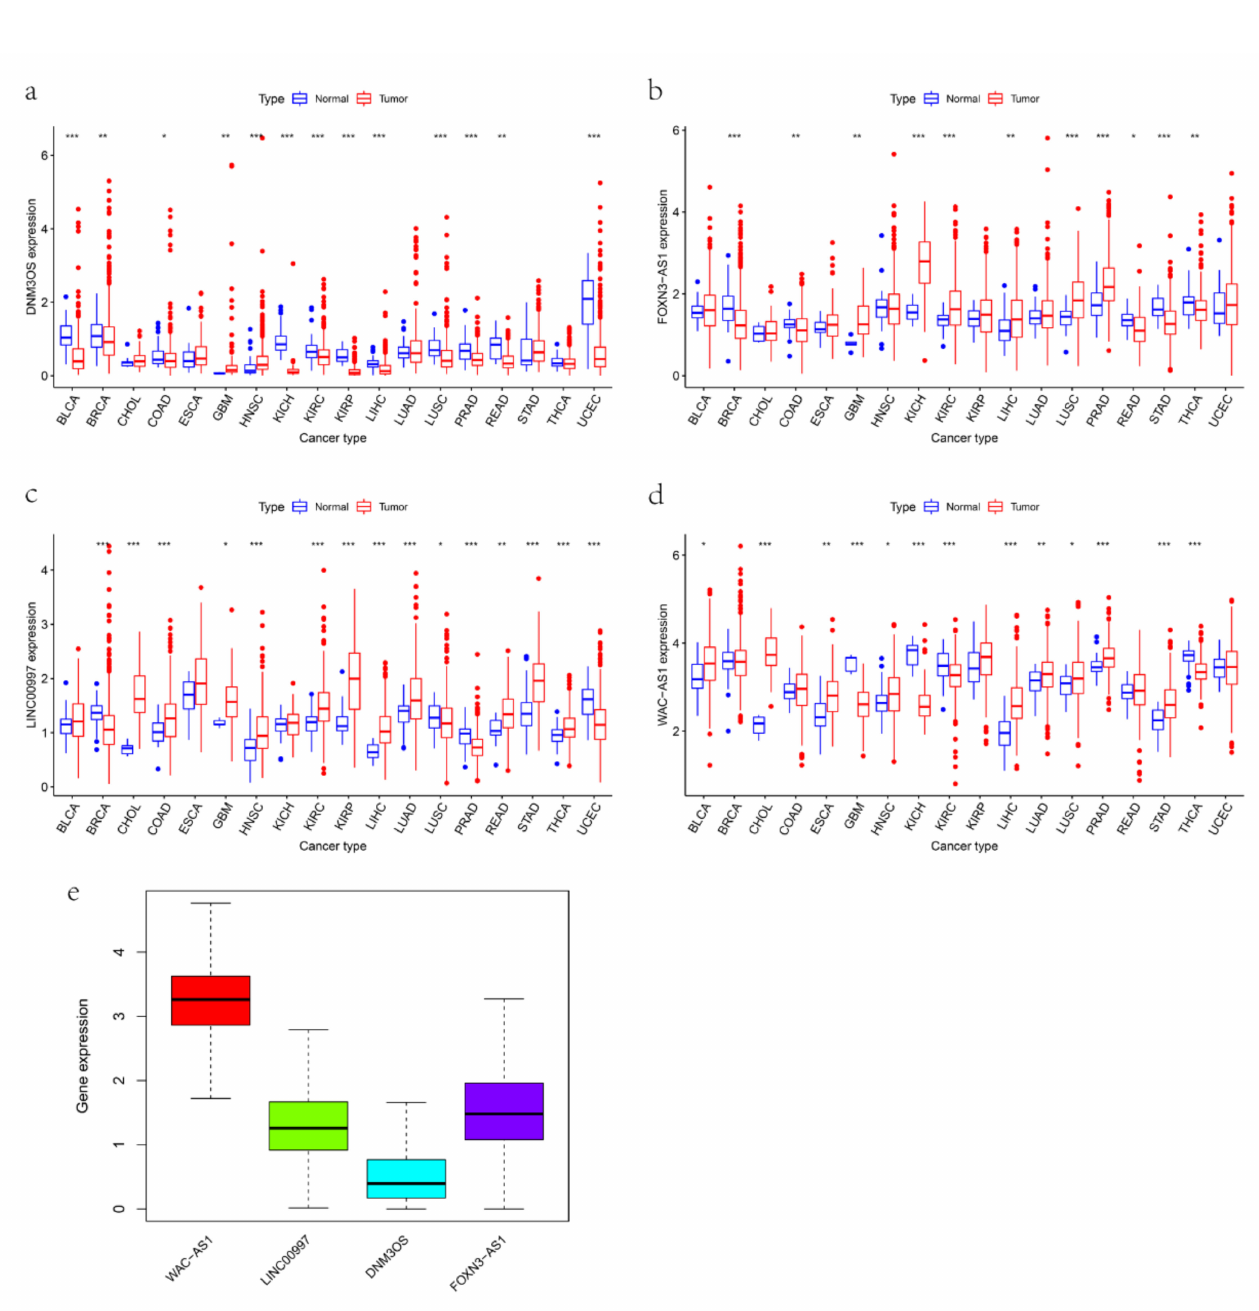
Figure 8. Expression of pan-cancer mRLs. ( a – d ) Boxplot showing the expression level of the mRLs in tumor tissue compared with normal tissue in 18 cancer types which were composed of at least 5 normal samples. ( e ) Boxplot showing the expression distribution of the mRLs across pan-cancer. * p < 0.05, ** p < 0.01 and *** p <